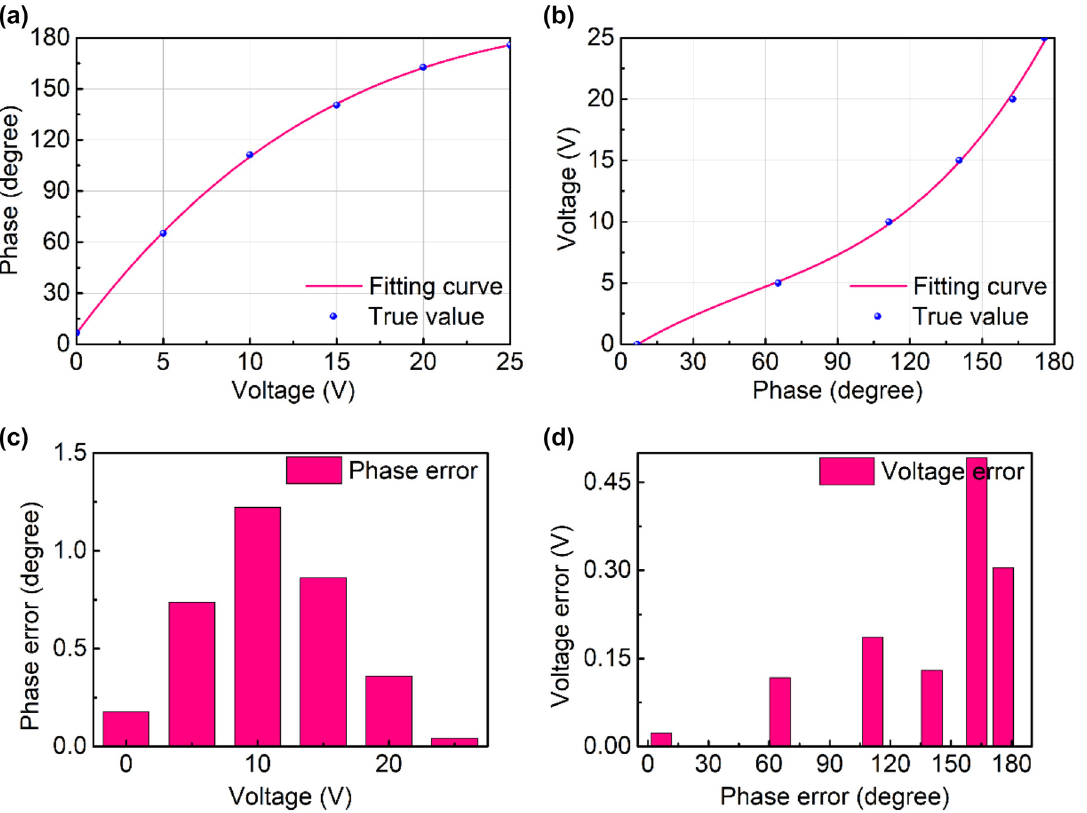
Figure 3: Bidirectional fitting of phase and voltage: (a) forward fitting from voltage to phase; (b) inverse fitting from phase to voltage; (c) phase error between the fitting and true value; and (d) voltage error between the fitting and true